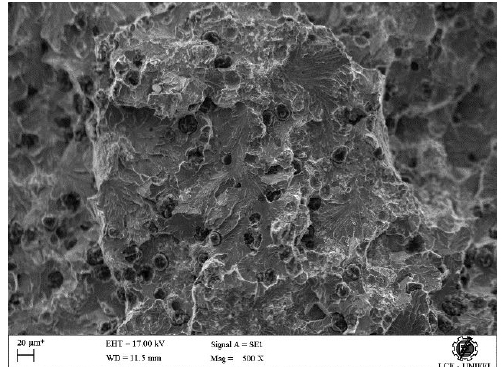
Figure 36. Fractured surface of